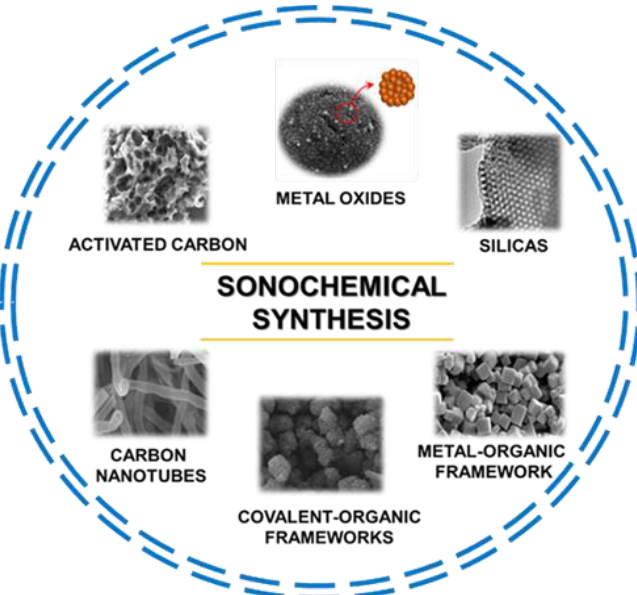
Figure 2. Schematic illustration of diverse nanoporous materials synthesized via a